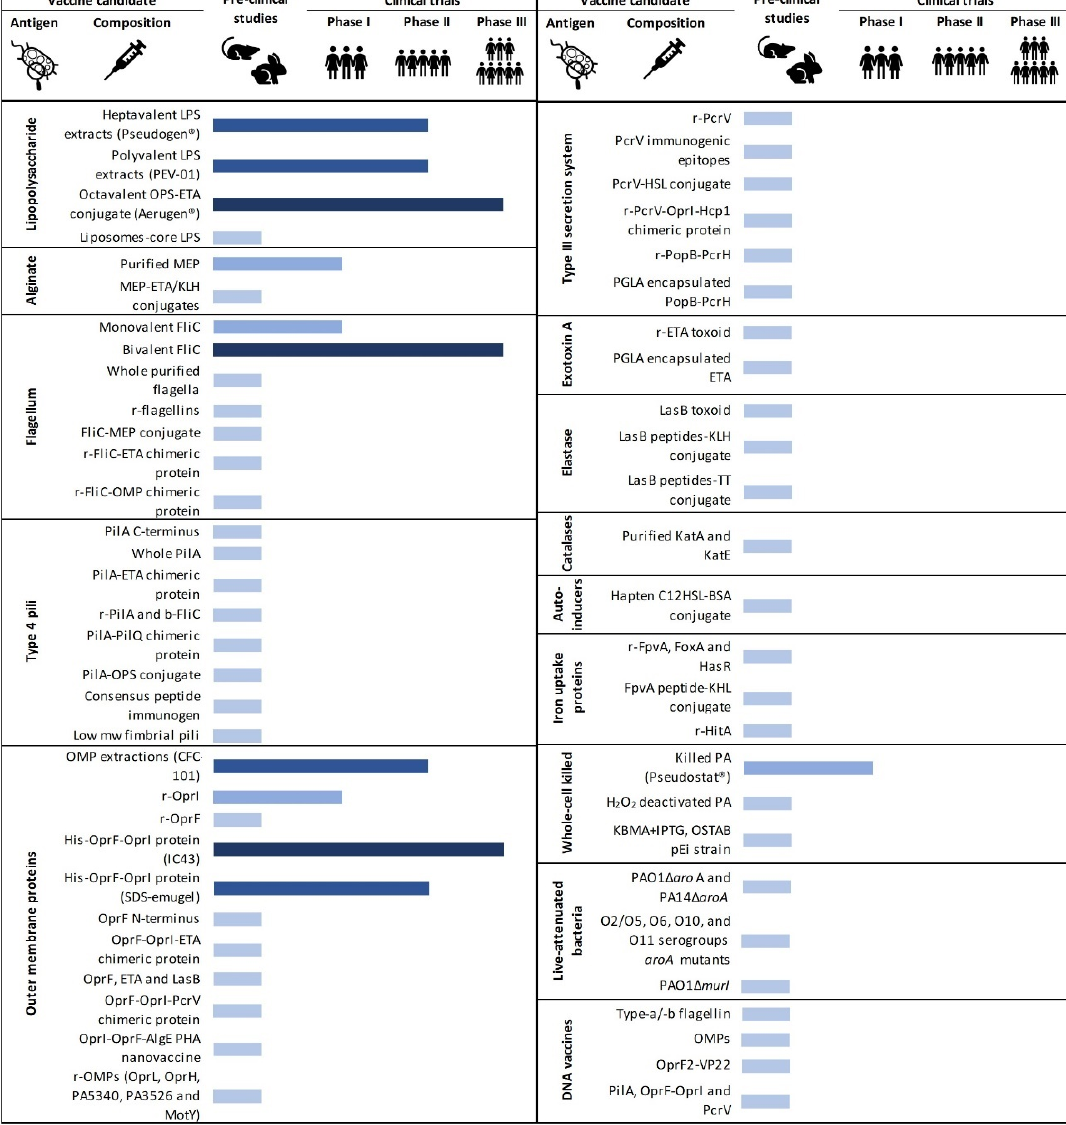
Figure 3. Progress in the development of a vaccine against P. aeruginosa infections. The darker the colour of bar, the further the vaccine candidate was evaluated.